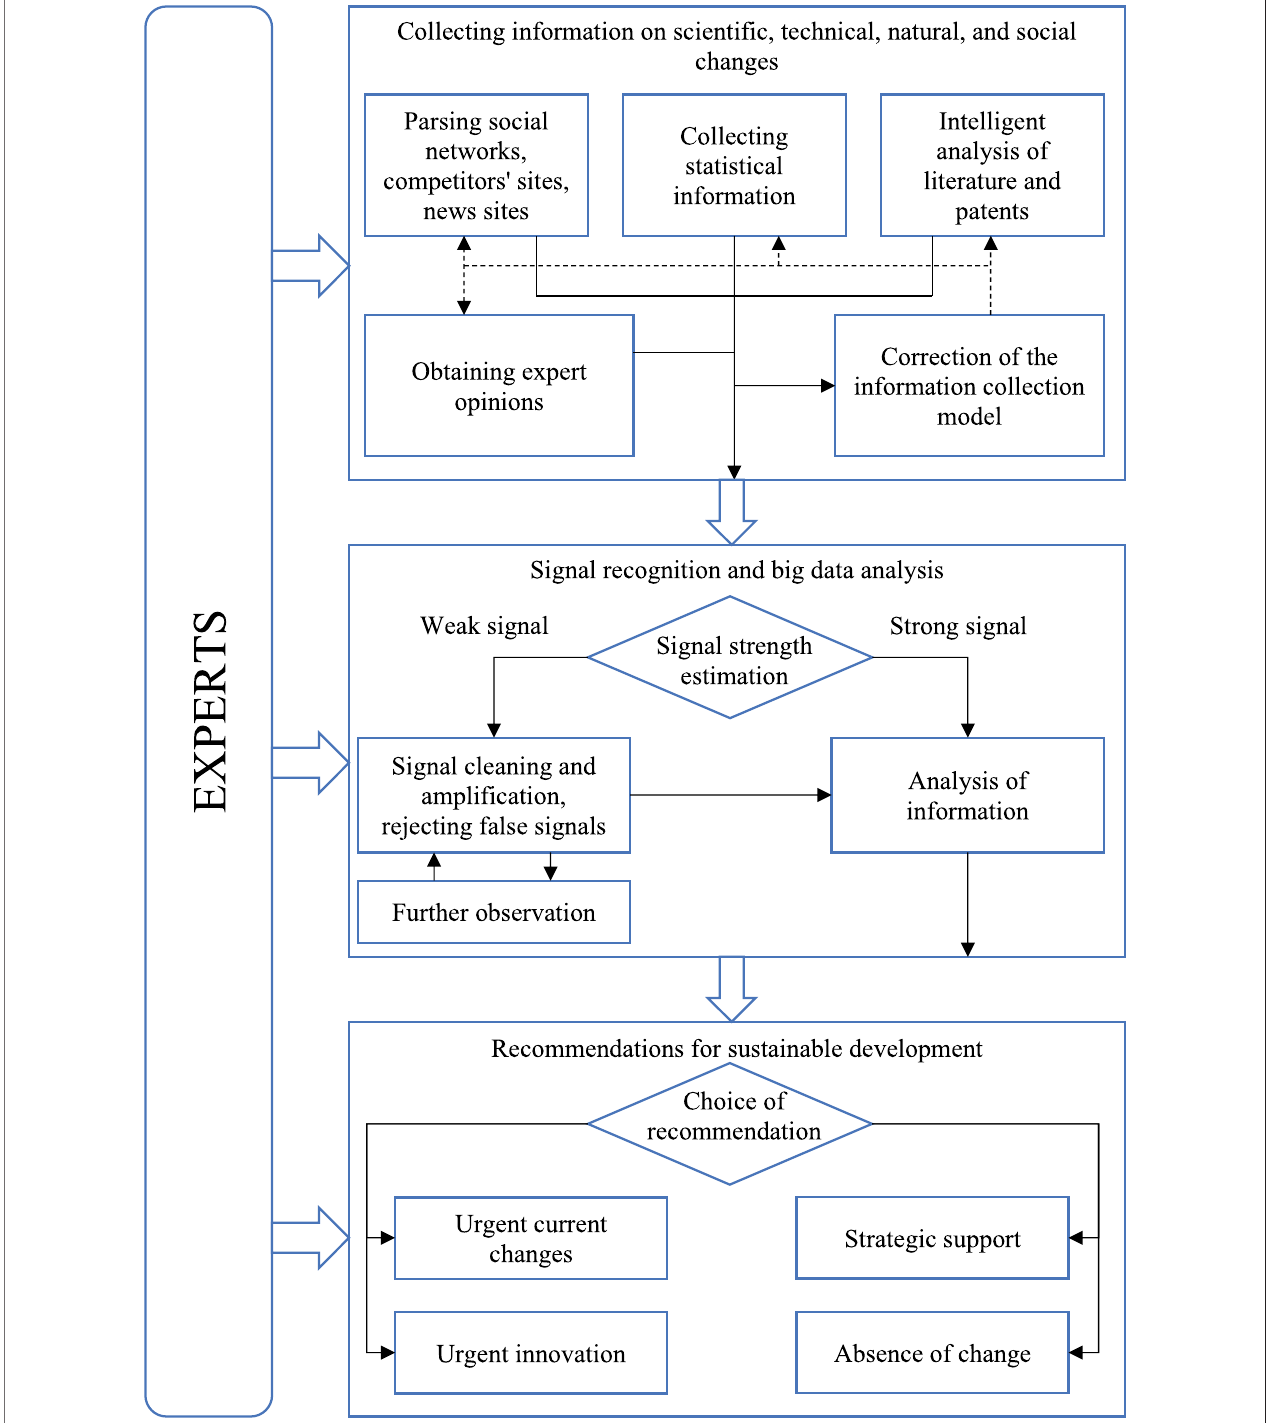
FIGURE 4 | Scheme of functioning of the expert system to support sustainable innovative development (Andreyeva et al., 2015).